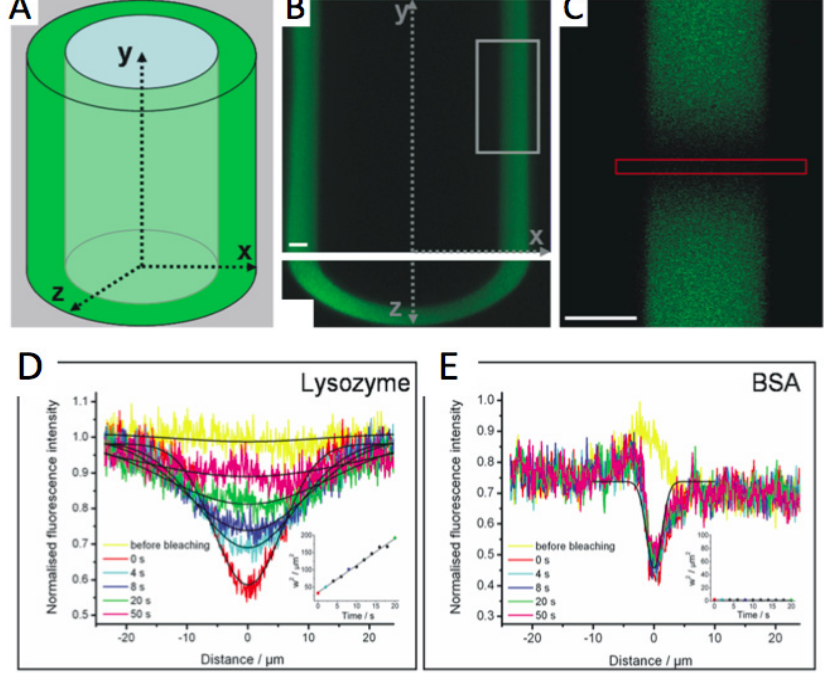
Figure 2. ( A ) Schematics of a glass fiber (in blue) coated with (HA/PLL) ( B ) CLSM cross-section ( x – y scanning) in the middle of a coated fiber (the film in green). In grey frame is the area considered for FRAP experiments; ( C ) Magnified image of the grey area in B, contrast enhanced image. In red frame is the photobleached area. Scale bars 10 µm; and ( D , E ) the mean fluorescence intensity profiles along the whole film as a function of time for lysozyme and BSA, respectively. The insets show the square width at half minimum of the Gaussian w 2 at different time intervals. Adopted from